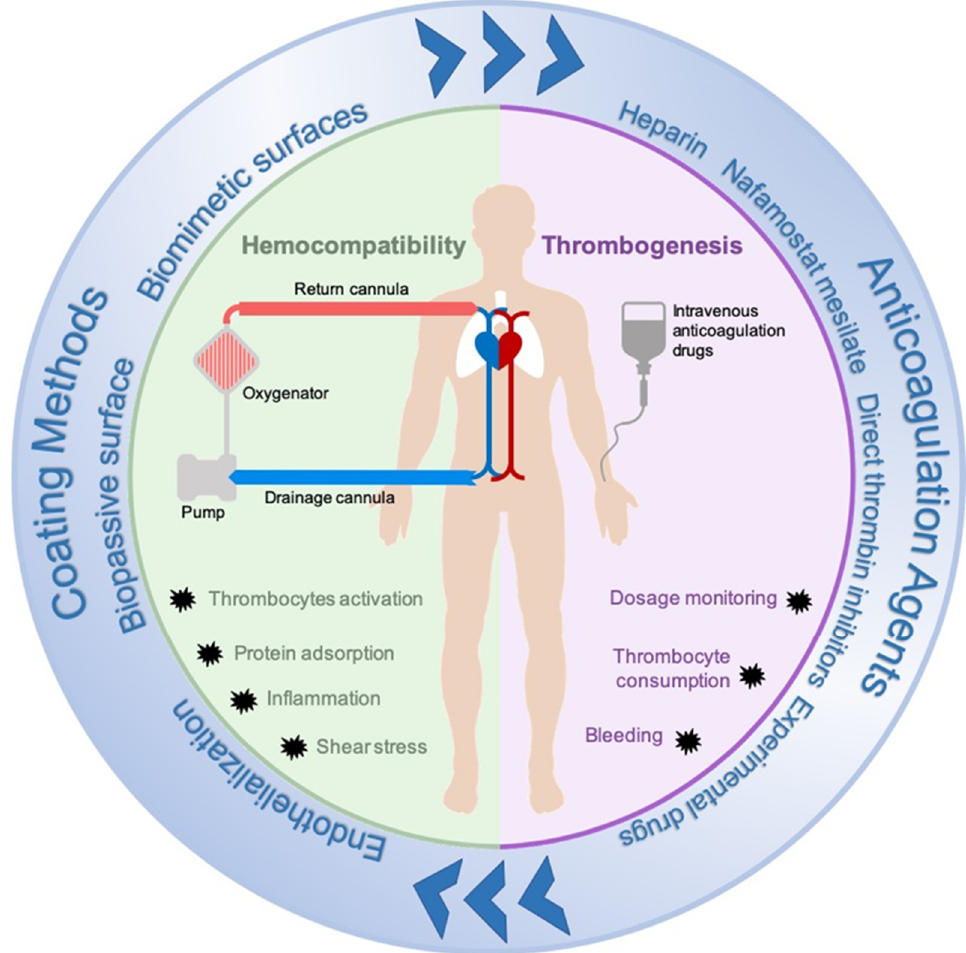
Figure 1. Visual summary of the interaction between hemocompatibility and thrombogenesis during extracorporeal life support and the adopted strategies to control it through anticoagulation agents and coating methods.